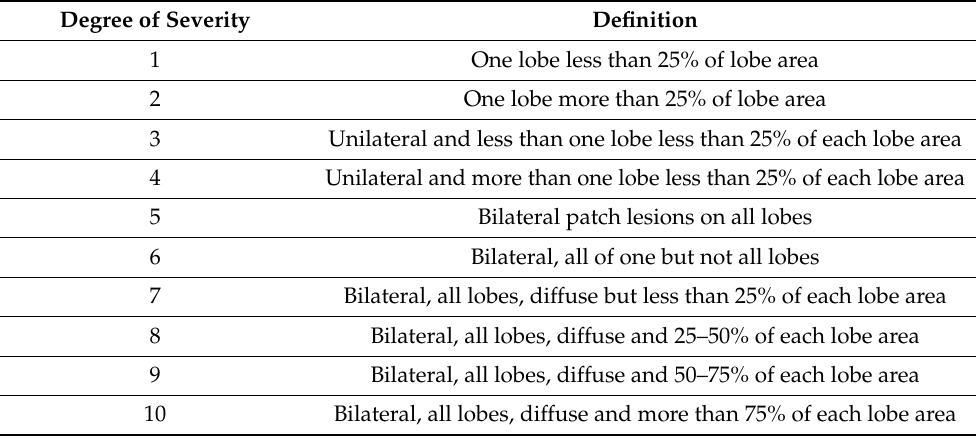
Table 3. Radiological Severity